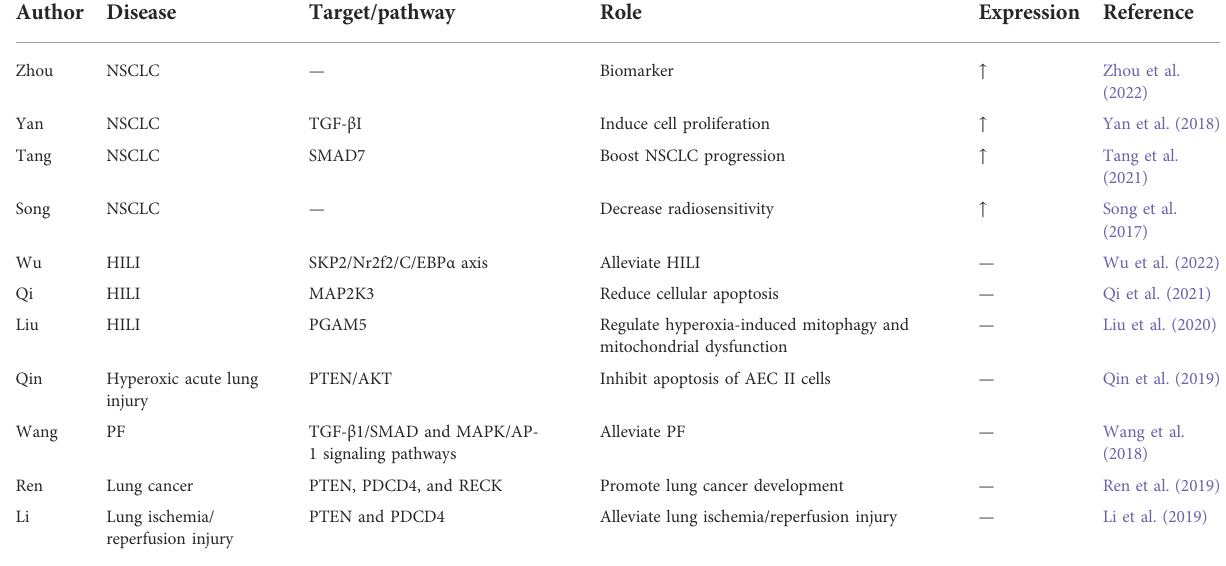
TABLE 3 The roles of miR-21-5p in lung